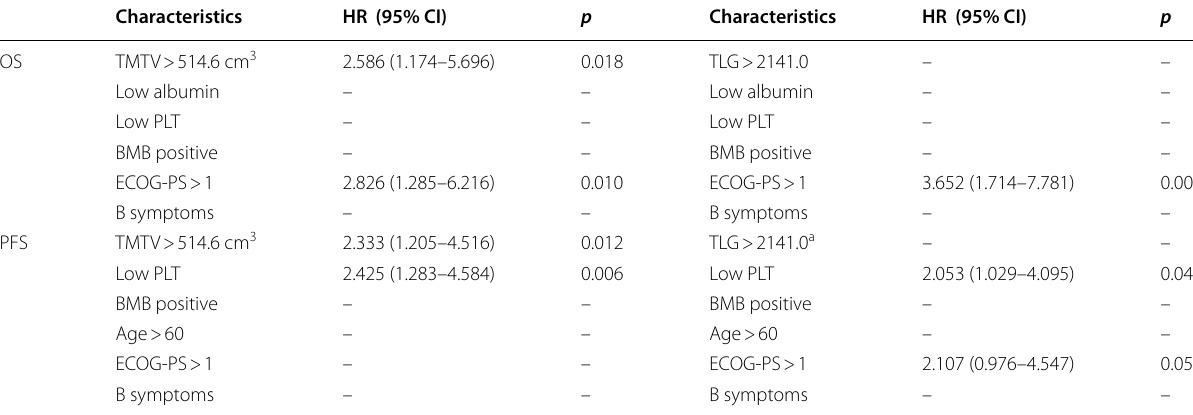
PFS, progression-free survival; OS, overall survival; HR, hazard ratio; CI, confidence interval; ECOG-PS, Eastern Cooperative Oncology Group Performance Status; PLT, platelet; BMB, bone marrow biopsy; TMTV, total metabolic tumour volume; TLG, total lesion glycolysis a TMTV and TLG were separately incorporated into multivariate survival analysis due to the correlation between TMTV and TLG